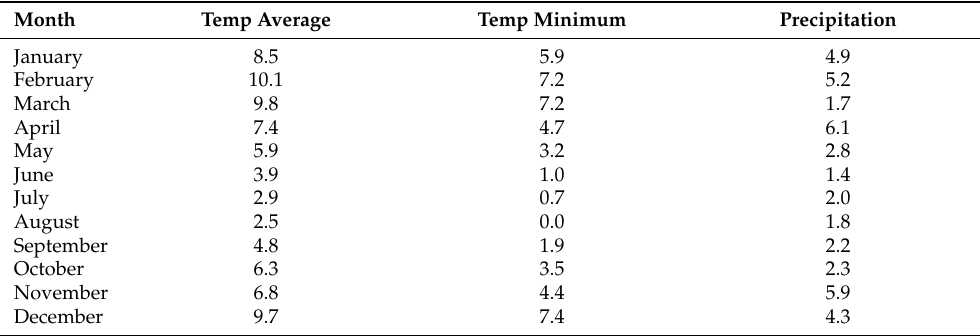
Table 8. Temperature (in °C) and precipitation (in mm) data for the year 2019 on the Tyndall Glacier